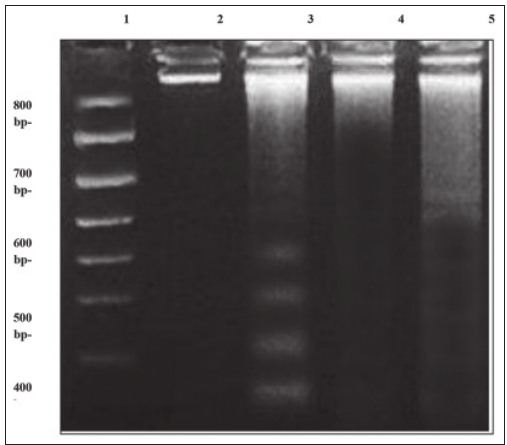
Figure-1: DNA fragmentation detected with agarose gel of DNA extracted from intestinal tissues of chicken by DNA gel electrophoresis laddering assay. Lane 1 represents DNA ladder. Lane 2 represents negative control chickens. Lane 3 represents chickens infected with C. perfringens . Lane 4 represents chickens treated with Na-butyrate. Lane 5 represents chickens infected with C. perfringens and treated with Na-butyrate.